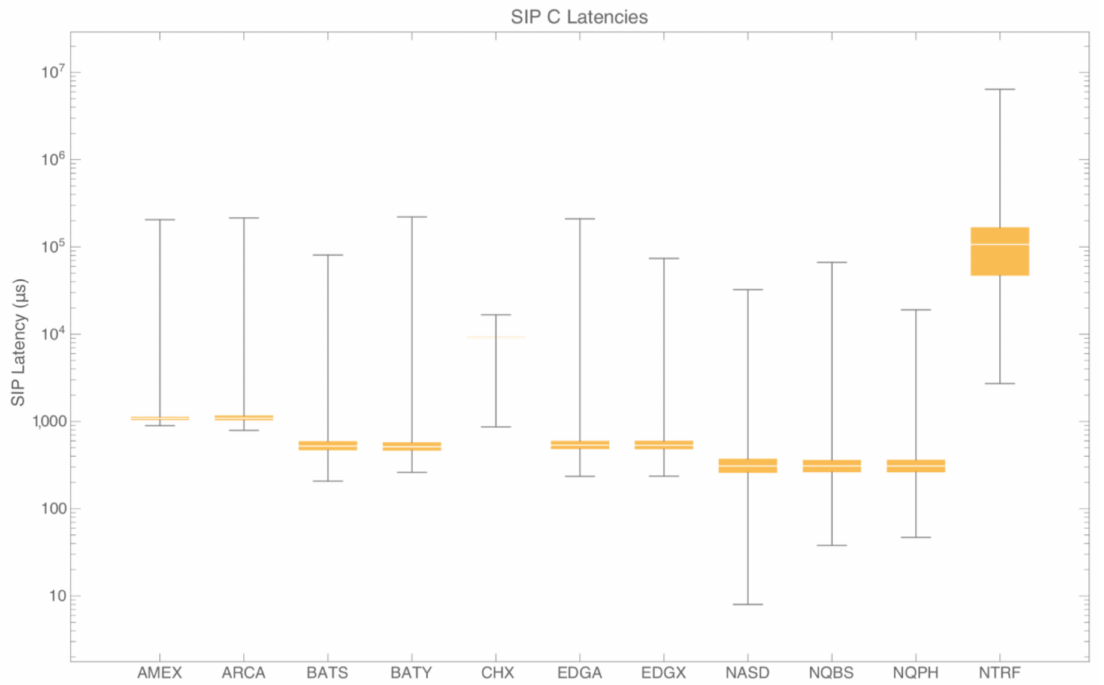
Figure 12. Box plots of latencies for all trades of all stocks traded on 11 August 2015 in microseconds reported by SIP C and separated by exchange.